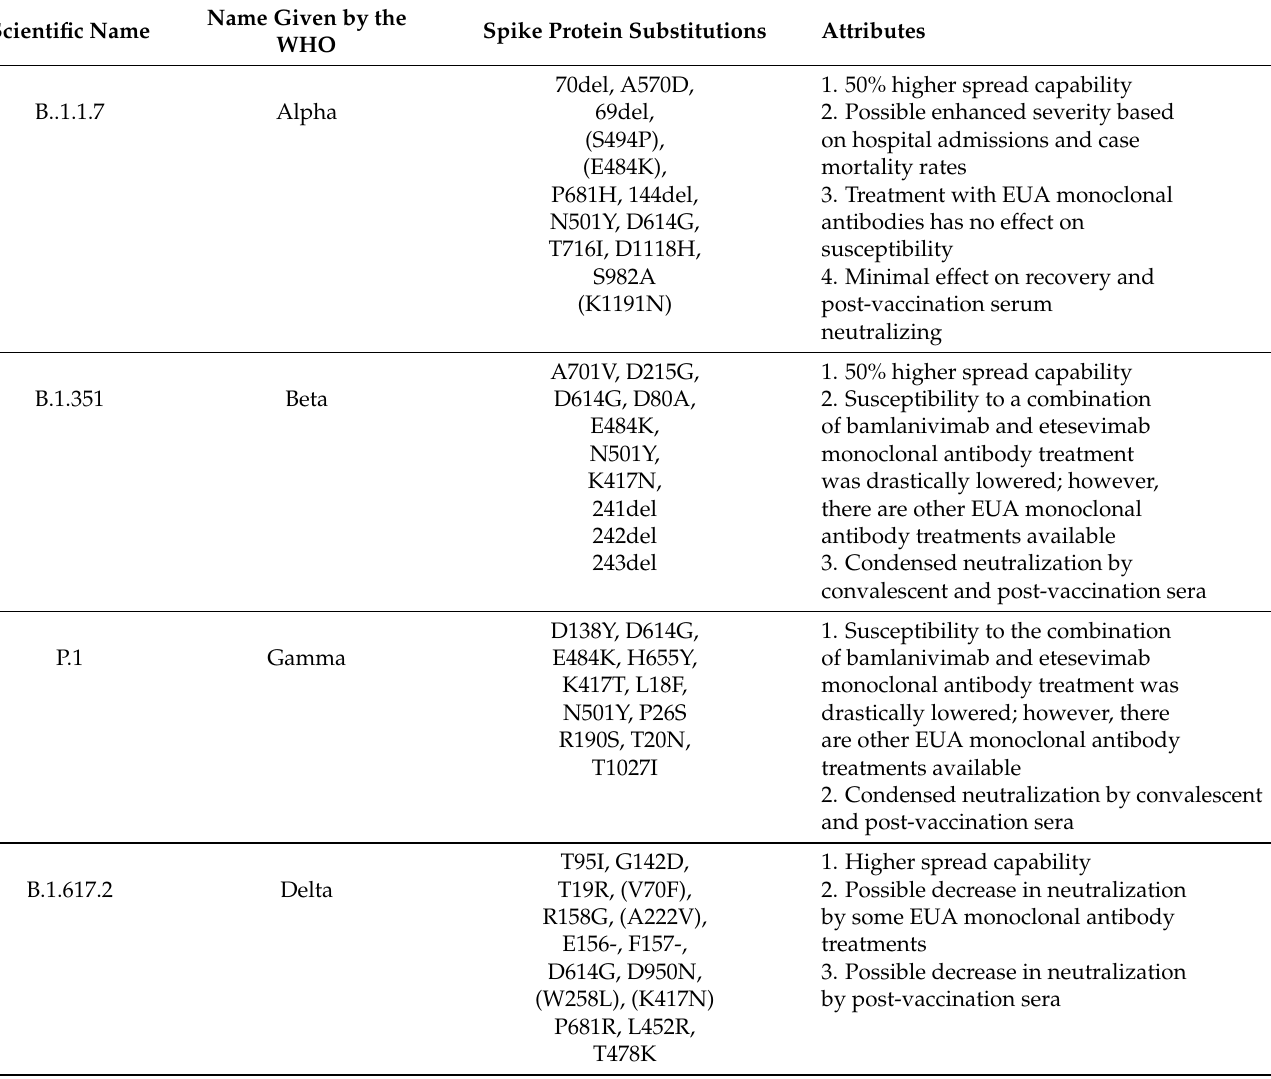
Table 1. Some of the recent variants categorized by